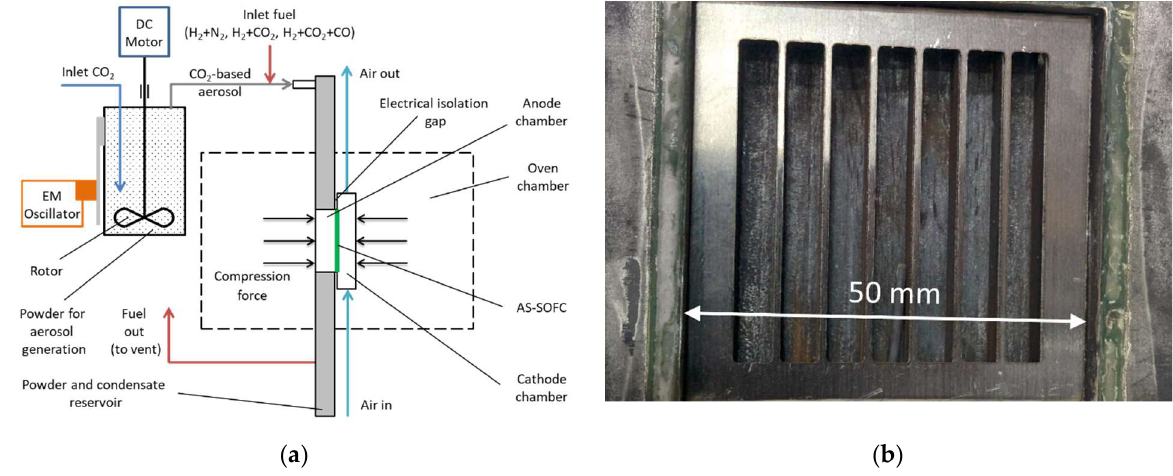
Figure 3. Test setup: ( a ) schematic chart of the vertically arranged sample holder and aerosol gen- erator; ( b ) photograph of the anodic current collector (visible 25 mm 2 area fuel channels).